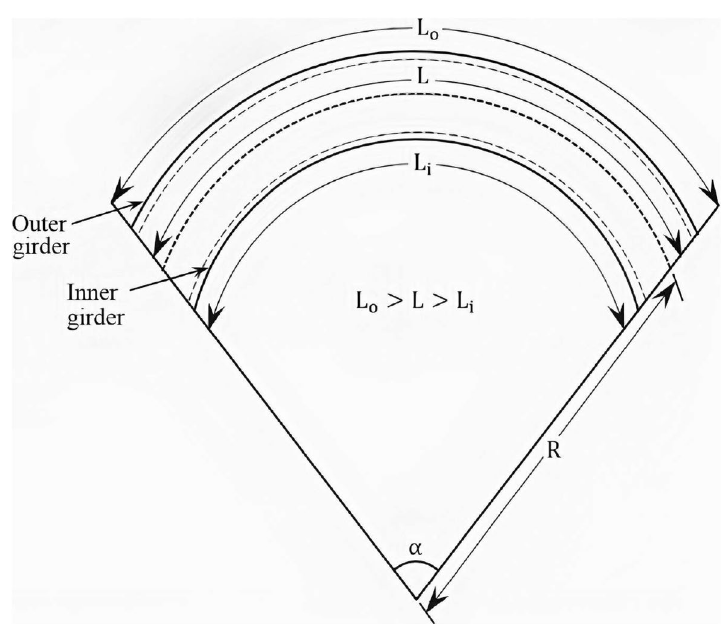
Fig. 1 Curved box-girder bridge